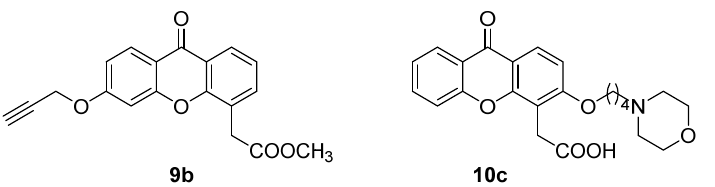
Figure 7. XAA derivatives selected for in vivo evaluation of antivascular properties.